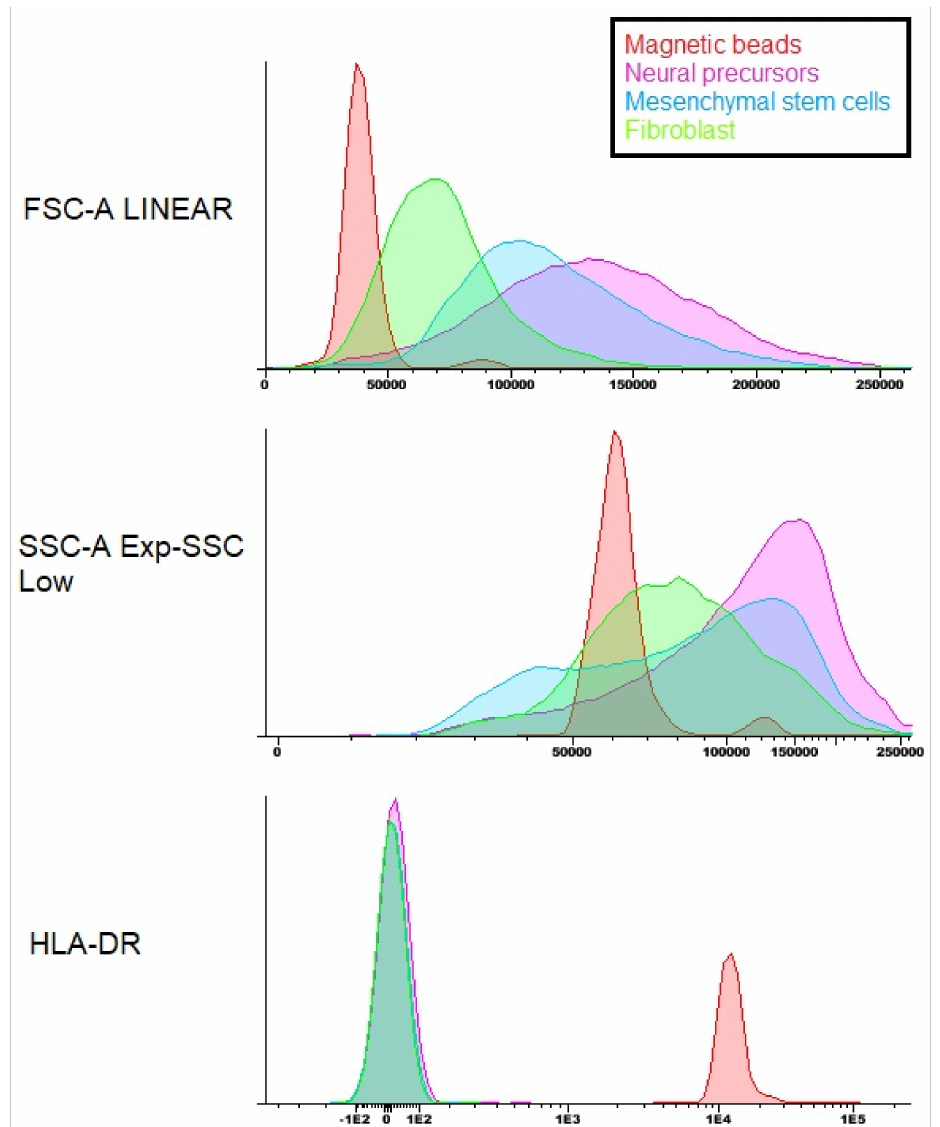
Figure 10. Flow cytometry of the HLA-DR histocompatibility complex molecule. Note: magnetic beads—red; Neural precursor—purple; MSC—blue;